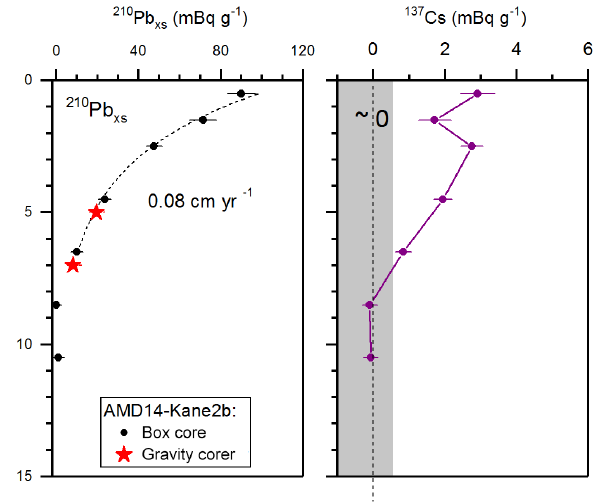
Figure 3. 210 Pb XS and 137 Cs profiles in AMD14-Kane2b box core (circles). 210 Pb XS data points in the top part of AMD-Kane2b grav- ity core have been shifted to obtain the best correspondence of the plots, yielding a material loss of 4cm at the top of the gravity